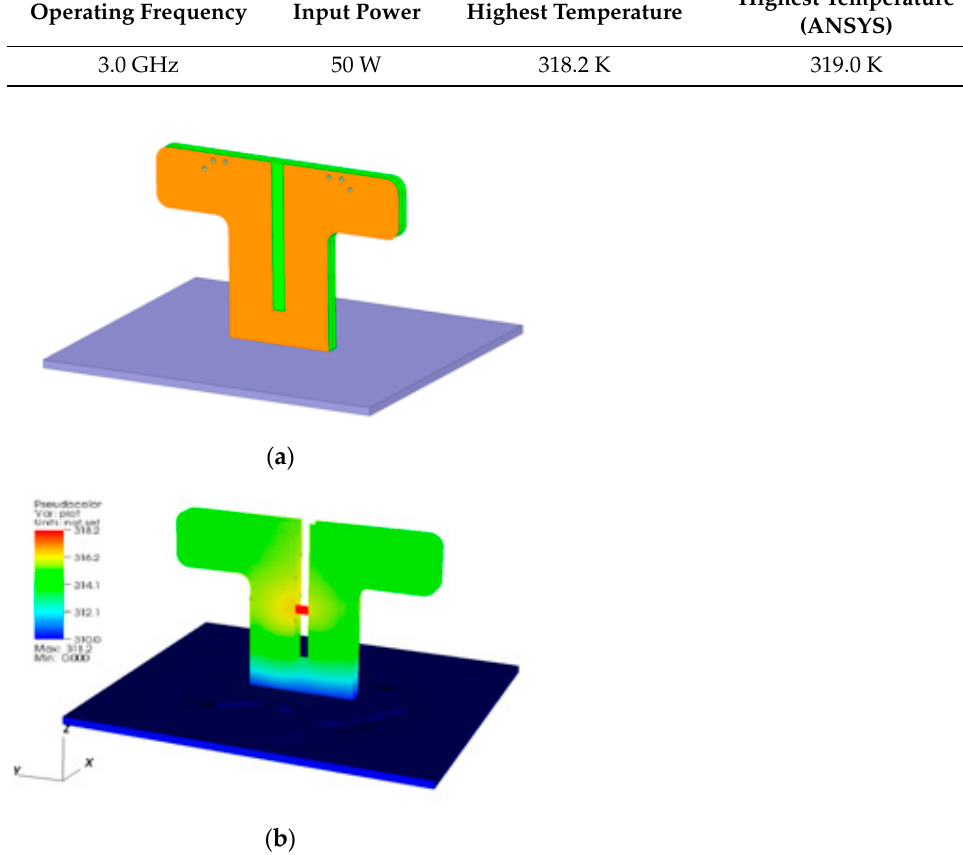
Table 1. Information of antenna element multiphysics simulation.